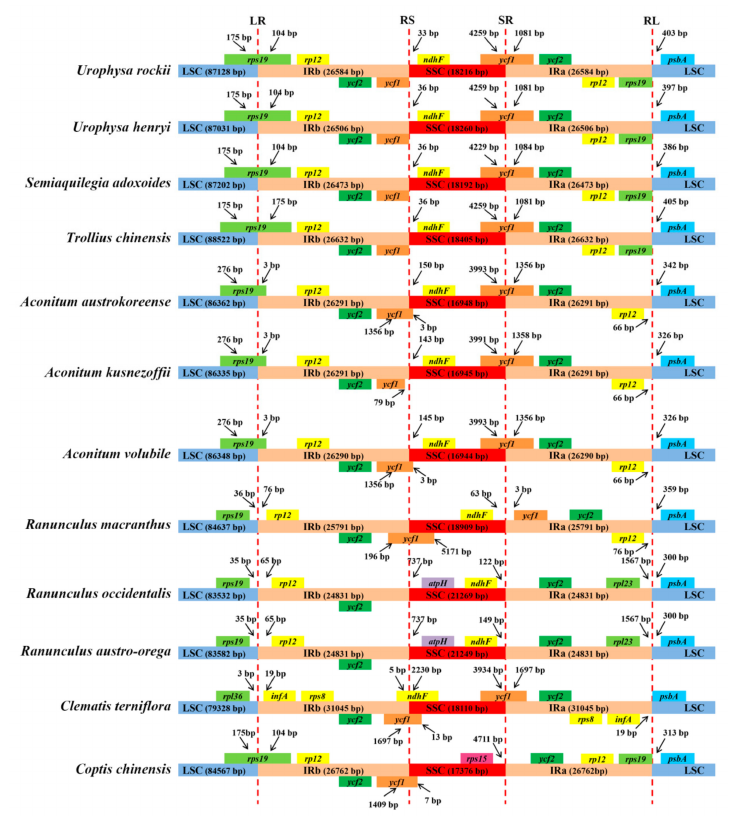
Figure 5. Comparison of the borders of the LSC, SSC, and IR regions of the chloroplast genomes of the three species. LR: junction line between LSC and IRb; RS: junction line between IRb and SSC; SR: junction line between SSC and IRa; RL: junction line between IRa and